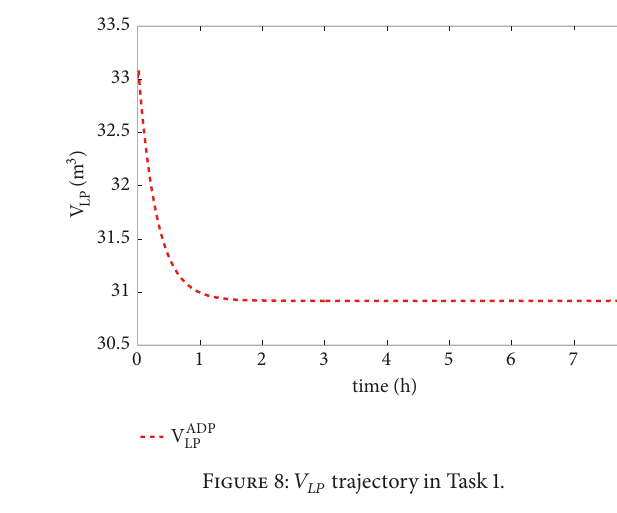
Figure 5: 𝐶 𝐹1 trajectory in Task 1.